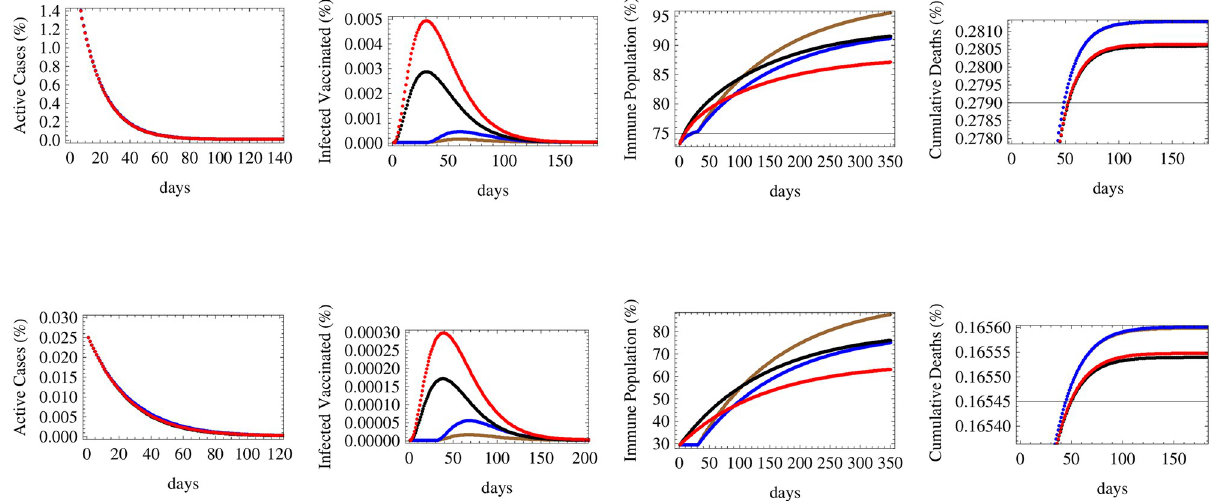
Fig 6. The figure shows the expected relative numbers of active cases, infected vaccinated cases, immune population and cumulative deaths at a low reproductive rate R = 0.7 in relation to four cases simulating the effect of efficacy and the time of initiation of the vaccination process: A vaccine of efficacy e = 52% to start deployment immediately (red), a vaccine of efficacy e = 72% to start deployment immediately (black), a vaccine of efficacy e = 72% to start deployment after 30 days (blue) and a vaccine of efficacy e = 92% to start deployment after 30 days (brown), all being deployed at an equal rate of 0.7% of the susceptible population per day. The upper row corresponds to initial conditions of 40.6% vaccinated population 1.8% currently infected and 0.18% dead while the lower row corresponds to 3.1% vaccinated population 0.46% currently infected and 0.11%